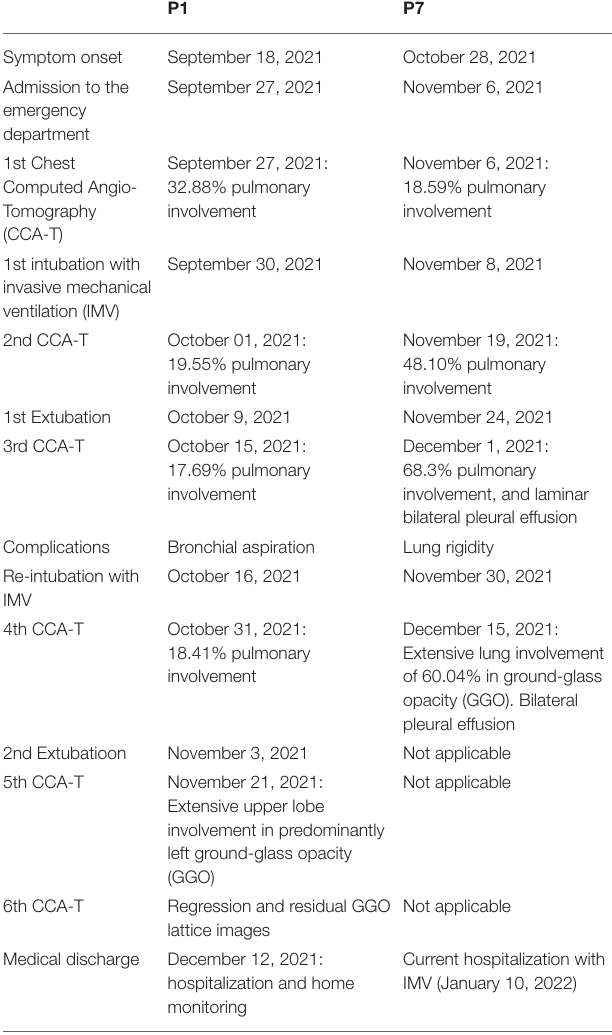
TABLE 3 | Progression of COVID-19 disease in vaccinated (P1) and non-vaccinated (P7) patients requiring invasive mechanical ventilation. P1